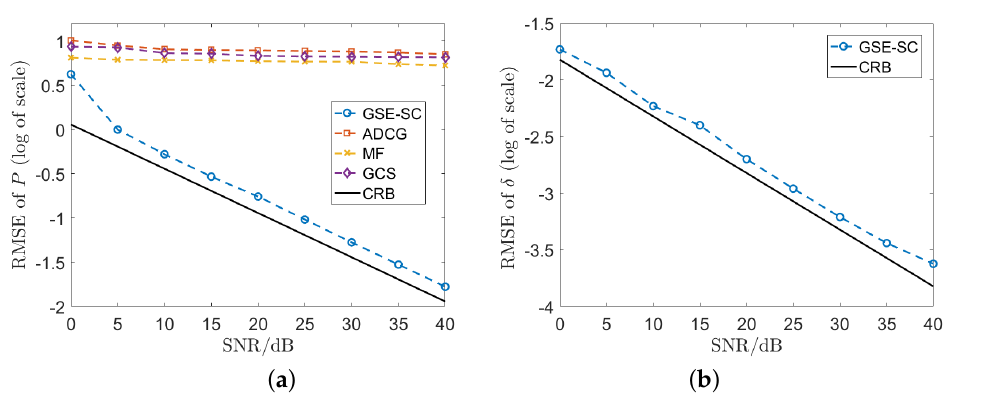
Figure 3. RMSEs of P and δ versus SNR. ( a ) RMSE of P ; ( b ) RMSE of δ .